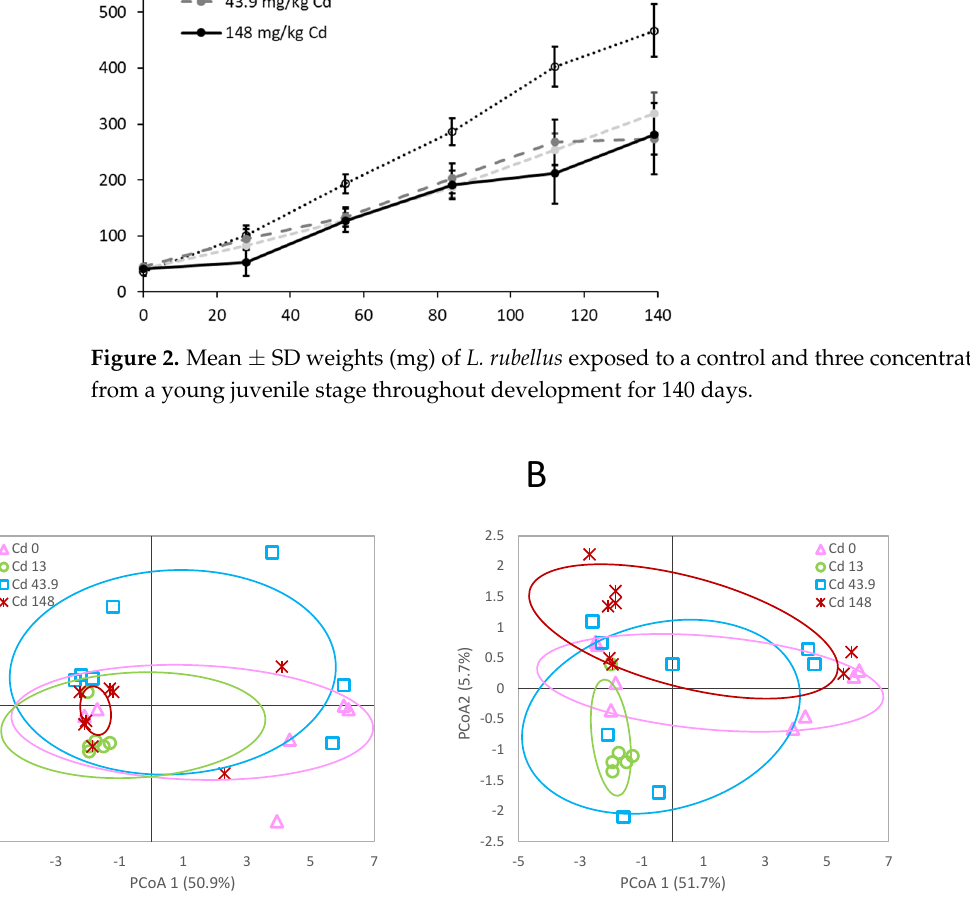
Figure 2. Mean ± SD weights (mg) of L. rubellus exposed to a control and three concentrations of Cd from a young juvenile stage throughout development for 140 days.